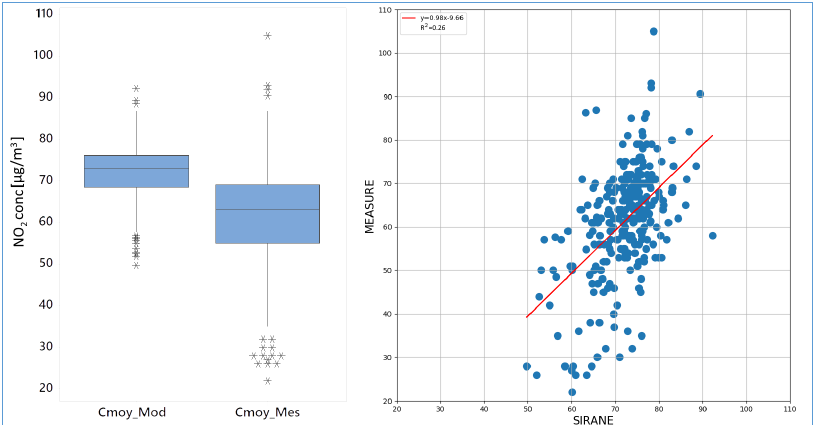
Figure 7. Time plot of NO 2 concentrations at Rebaudengo (elaboration by means of Python 3.6.5).